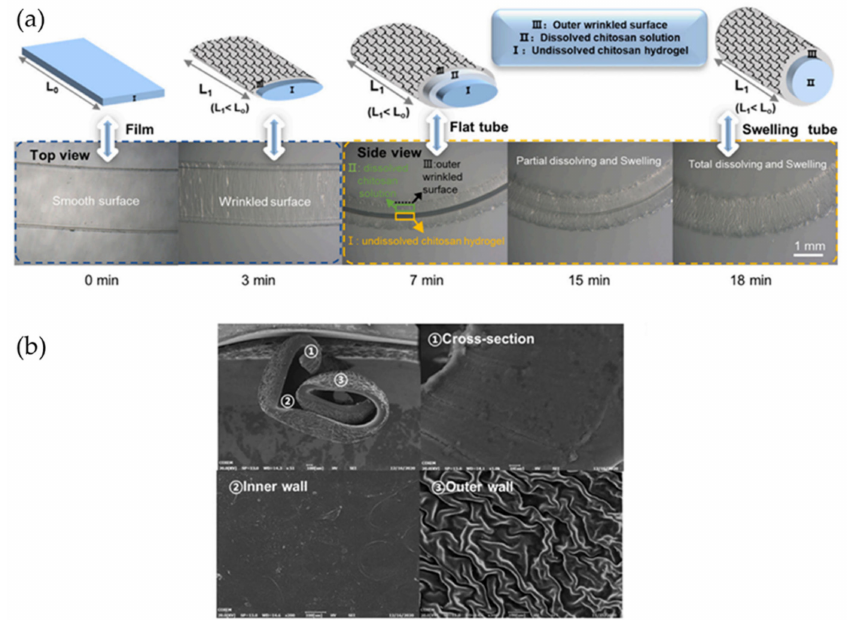
Figure 31. Wrinkled pattern tube formation process. ( a ) Microscopic and scheme of wrinkled tube device and ( b ) Cross-section morphology of the inner and outer wall of the wrinkled tube. Reproduced with permission from reference [123]. Copyright 2019, American Chemical Society